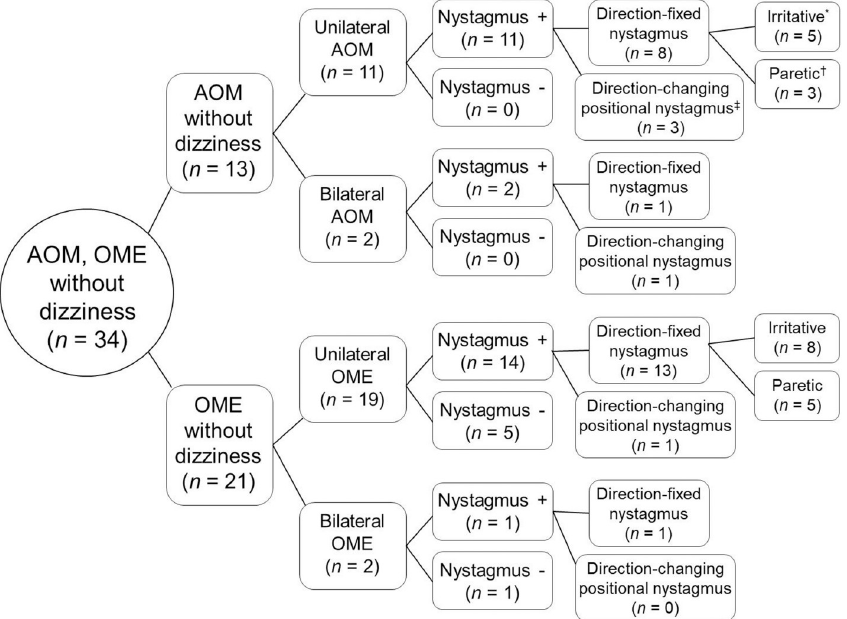
Fig 1. A diagram demonstrating the classification of nystagmus in adult patients of AOM or OME without dizziness ( n = 34). � Irritative-type nystagmus beats toward the lesioned ear. † Paretic-type nystagmus beats toward the healthy ear. ‡ Direction-changing positional nystagmus was indicated when the direction of nystagmus was changed from that of spontaneous nystagmus by positioning maneuvers.